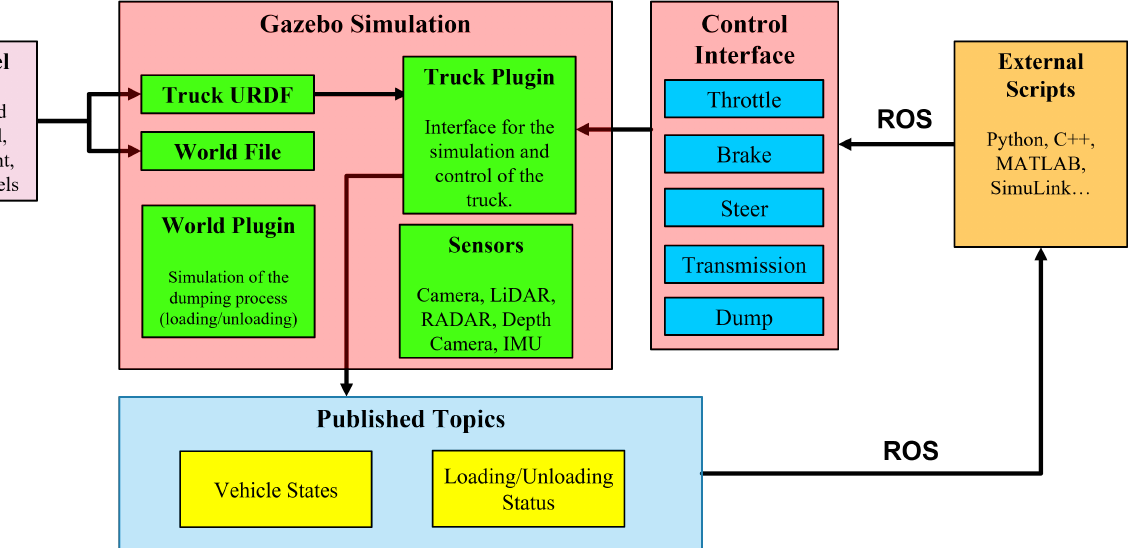
Figure 3. Architecture of the Oztech MODE simulator. The environment consists of four main components: the simulated vehicle and world built on top of Gazebo, the 3D models, the control and communication interface through ROS, and the external